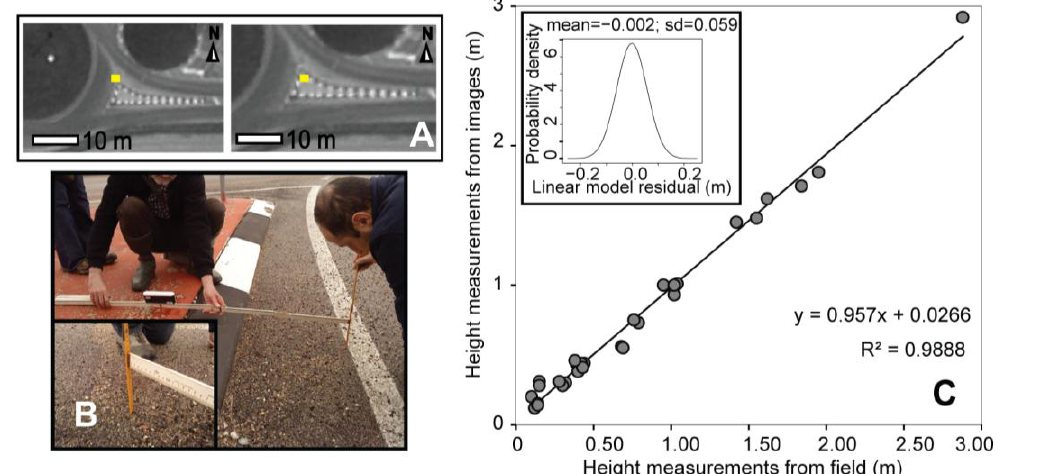
Figure 11. ( A ) Example of an object that was selected as a reference during the field survey (the points that were used to calculate and measure the height difference are shown in green). ( B ) Measurement of the height difference of a stable object in the field. ( C ) Correlation between the heights that were measured in the field and the corresponding heights that were derived from the satellite stereo images. The inset shows the error, which is modelled by a normal distribution.